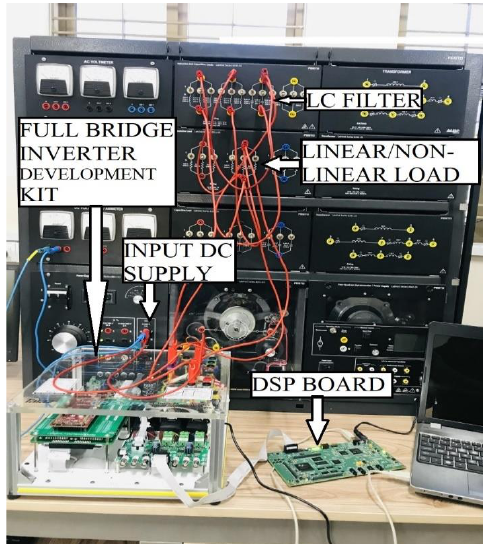
Figure 10. Experimental setup.